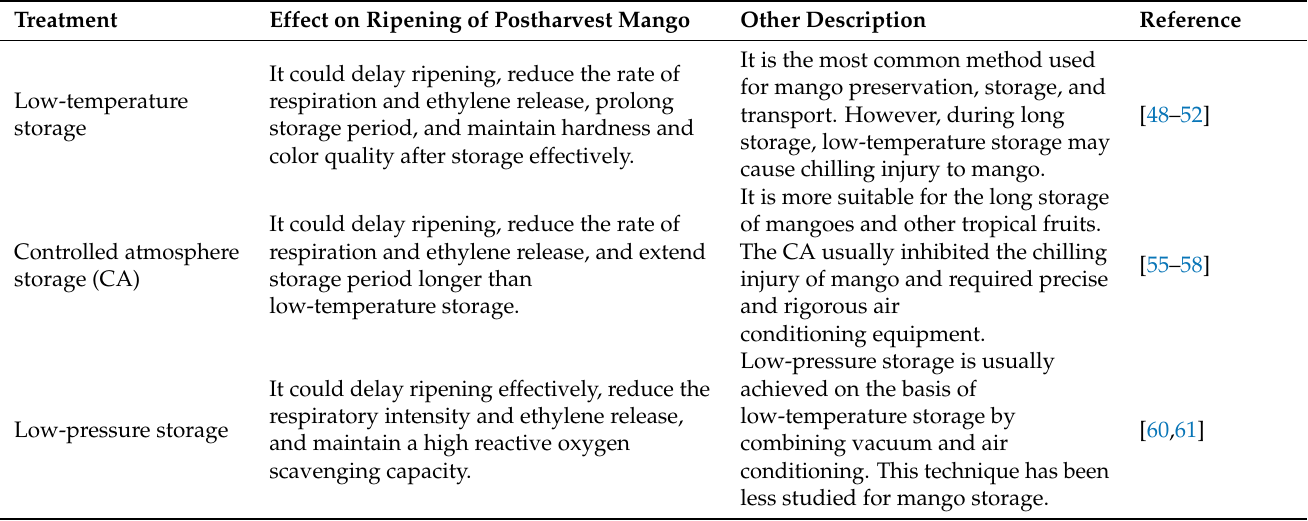
Table 1. Effects and comparison of different physical treatments on postharvest mango ripening. Treatment Effect on Ripening of Postharvest Mango Other